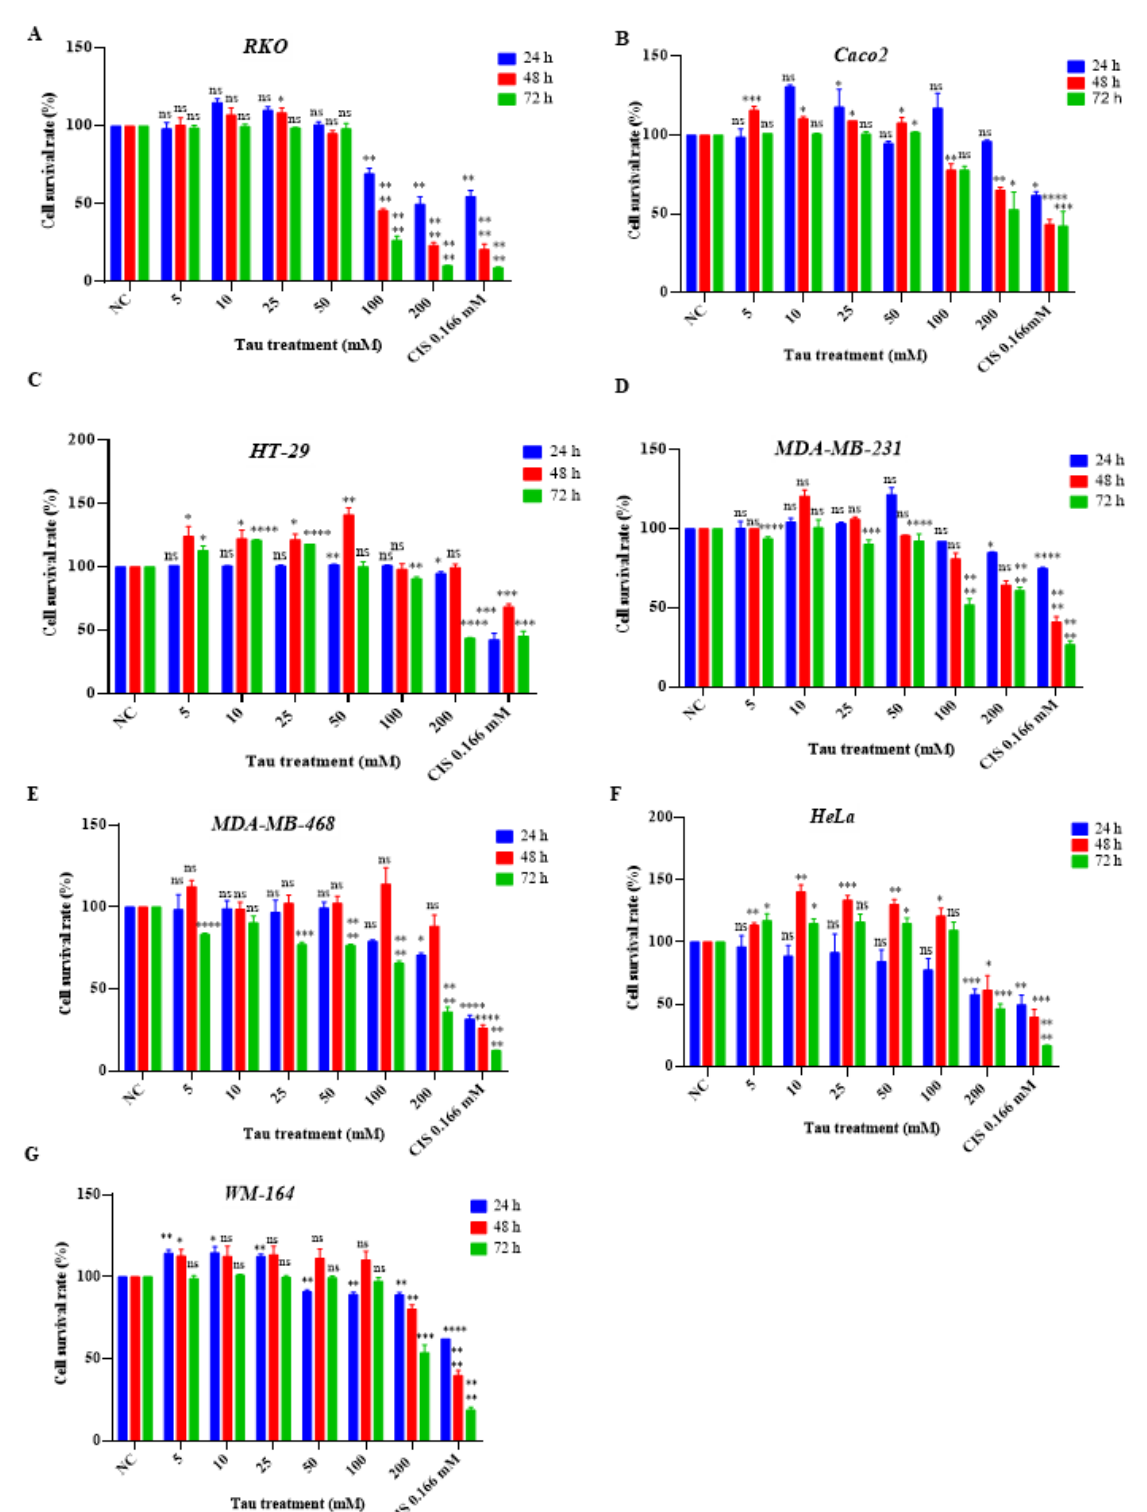
Figure 2. Tau is cytotoxic on a wide spectrum of cancer cells. The following cells: ( A ) RKO, ( B ) Caco2, ( C ) HT-29 ( D ) MDA- MB-231, ( E ) MDA-MB-468, ( F ) HeLa, ( G ) WM-164 cells were treated with (5–200 mM) Tau or 0.166 mM CIS for 24–72 h. The percentage of viable cells upon BAT or Tau treatment versus negative control (NC) was assessed, using the Crystal Violet procedure and statistical analysis was performed. ns: not significant, * p < 0.05. ** p < 0.01. *** p < 0.001. **** p < 0.0001.